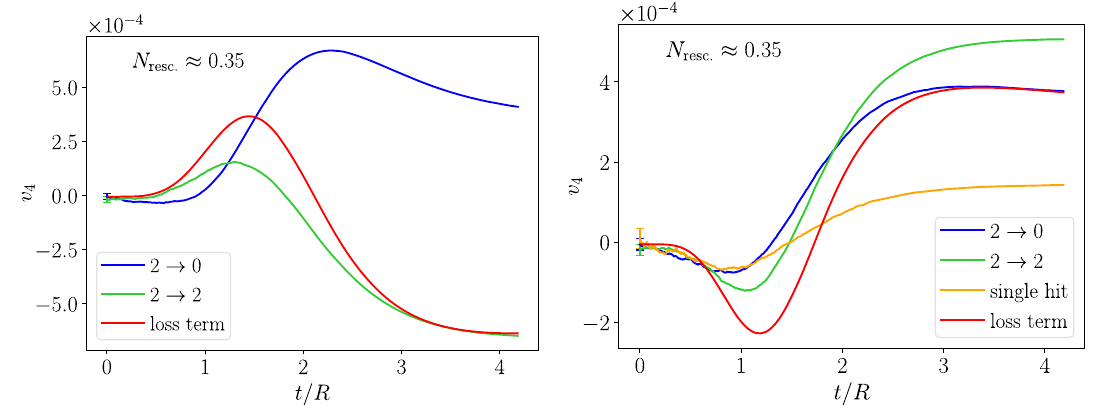
Fig. 13 Time-dependence of quadrangular flow v 4 in systems with N resc . ≈ 0 . 35 rescatterings per particle on average. Left: system with an initial ε 4 = 0 . 15 and ε 2 = 0; right: system with an initial state ε = 0 . 15 and ε = 0. The green curves are for systems with elastic 2 4